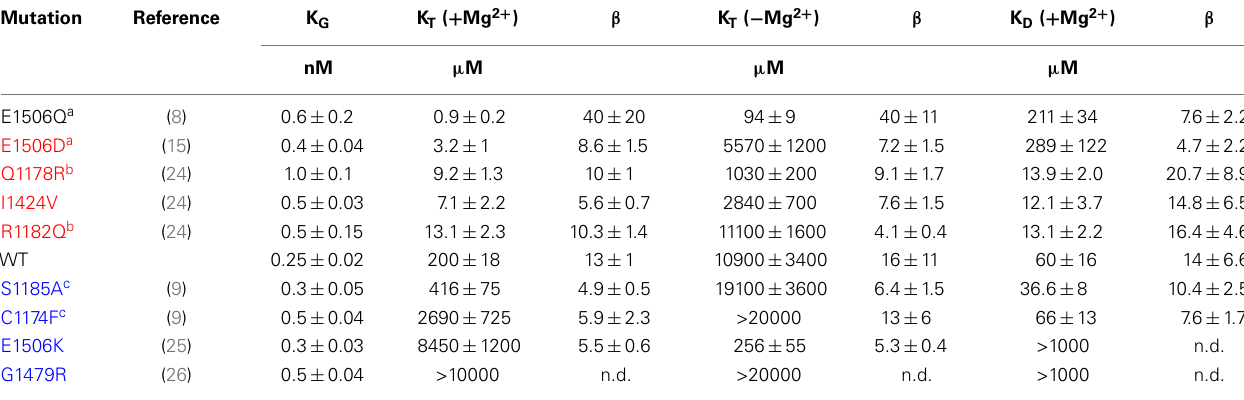
Table 1 | Comparison of binding parameters for neonatal diabetes and congenital hyperinsulinism